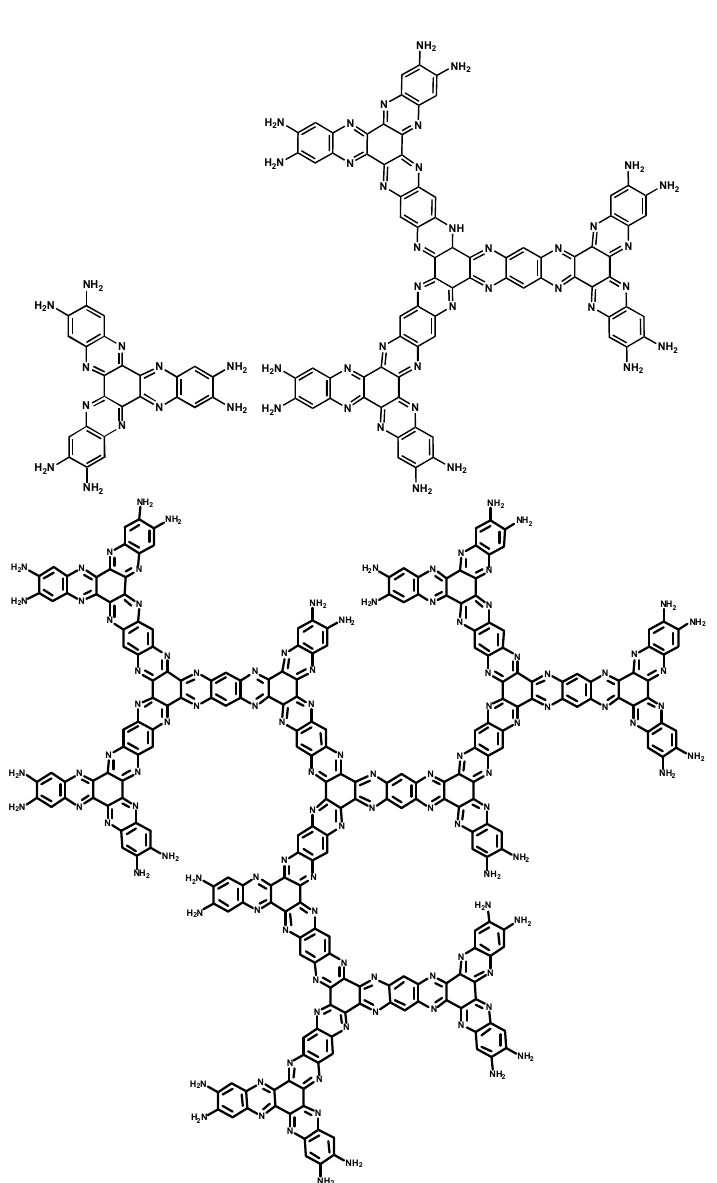
Figure 1. New π -conjugated dendritic architectures of Hexaazatrinaphthylenes (HATNAs) ( G1 , G2 and G3 ).